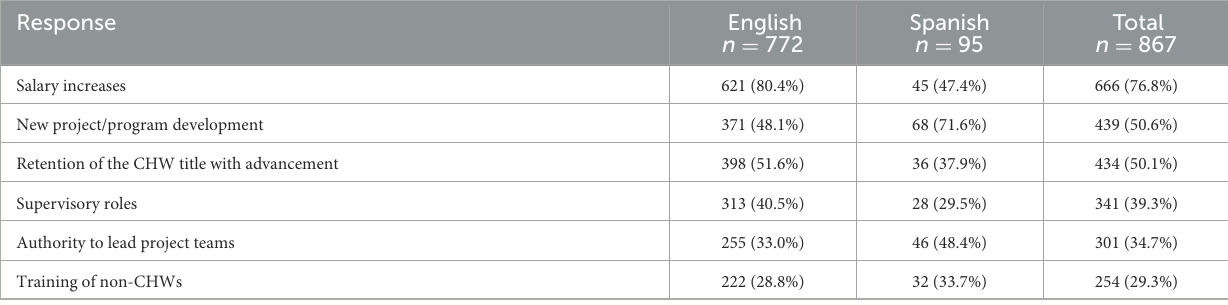
TABLE 1 Top options that CHWs believe should be incorporated into a CHW career path.